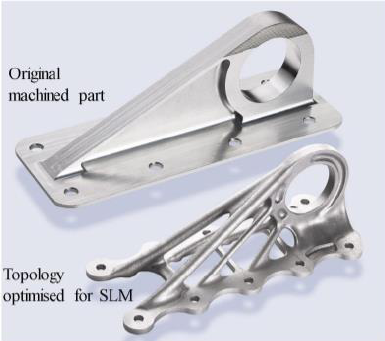
Figure 5. Cabin bracket, reproduced from [61].